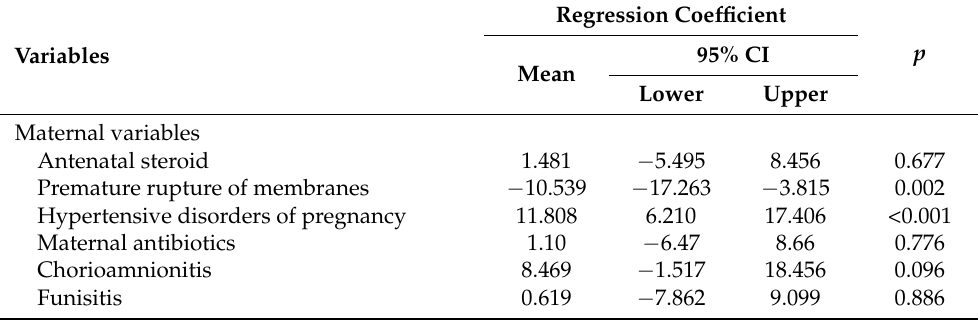
Table 2. Crude dependence of alpha 1 acid glycoprotein levels on clinical